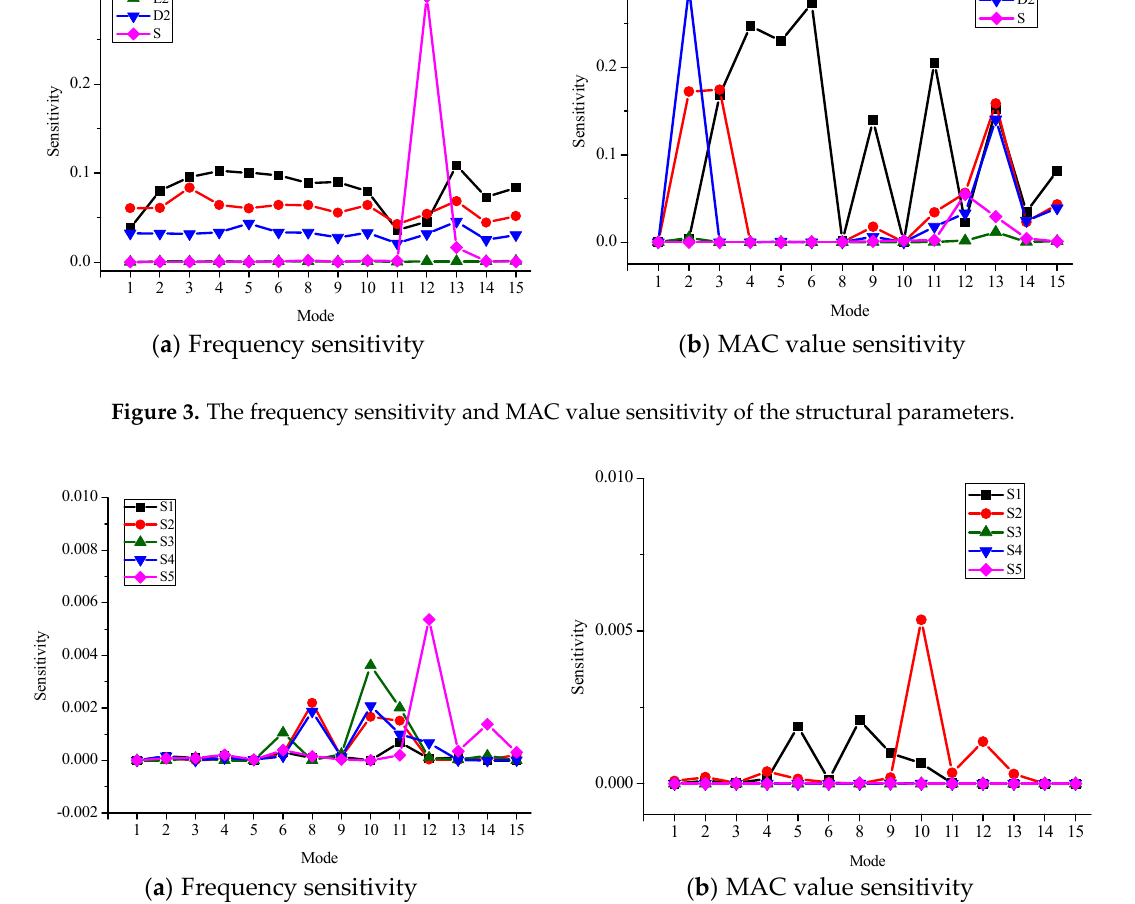
Figure 4. The frequency sensitivity and MAC value sensitivity of the stiffness of five supports.